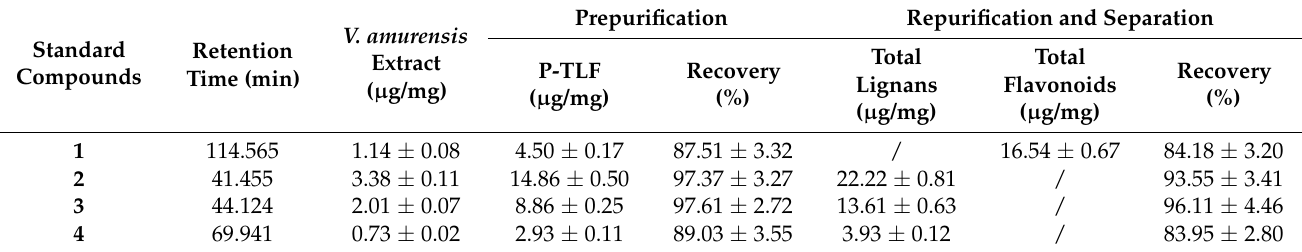
Table 3. The content or recovery of standard compounds 1–4 in V. amurensis extract, P-TLF, repurified total lignans and